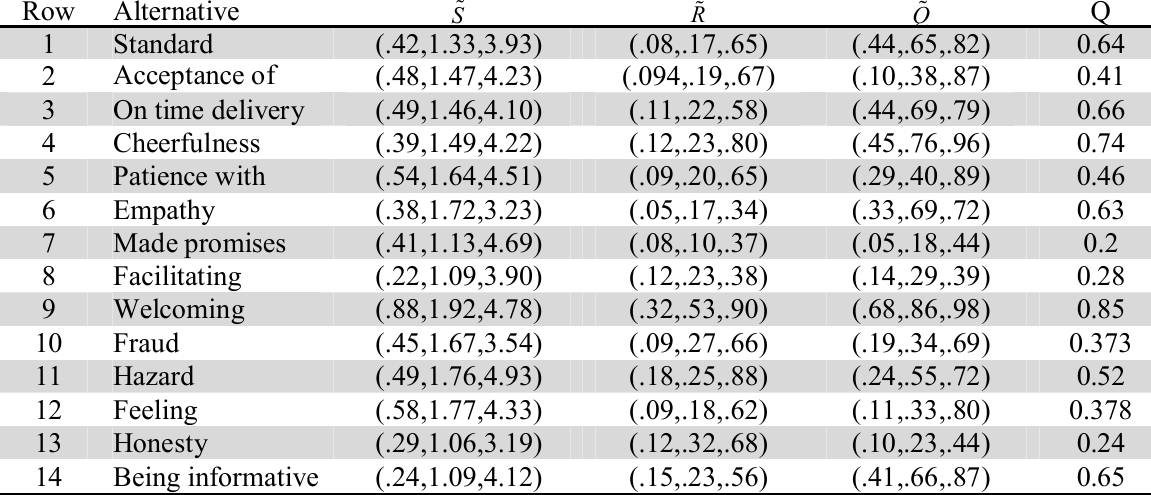
The summary of VIKOR